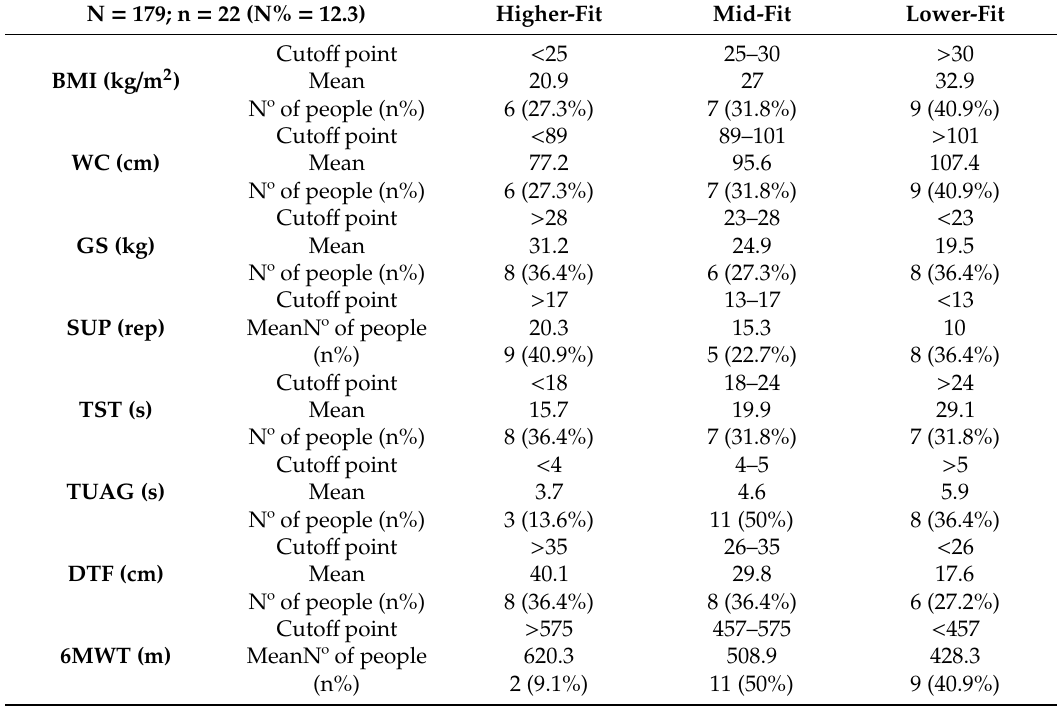
Table 3. Older men ( > 50 years old) results for each variable categorized in 3 physical fitness levels. N = 179; n = 22 (N% = 12.3)